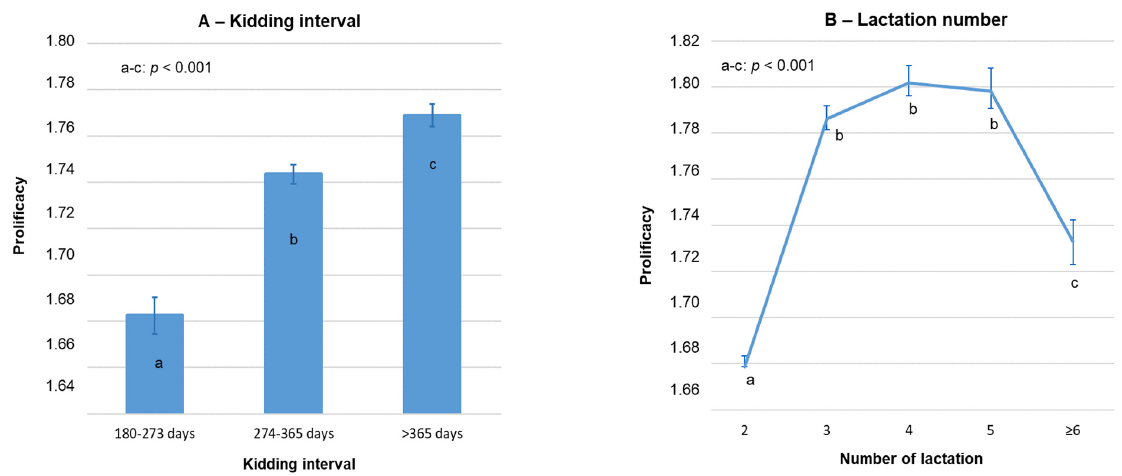
Figure 2. Variation in prolificacy of multiparous Florida goats according to kidding interval (A) and lactation number ( B ). Error bars = ± standard error.